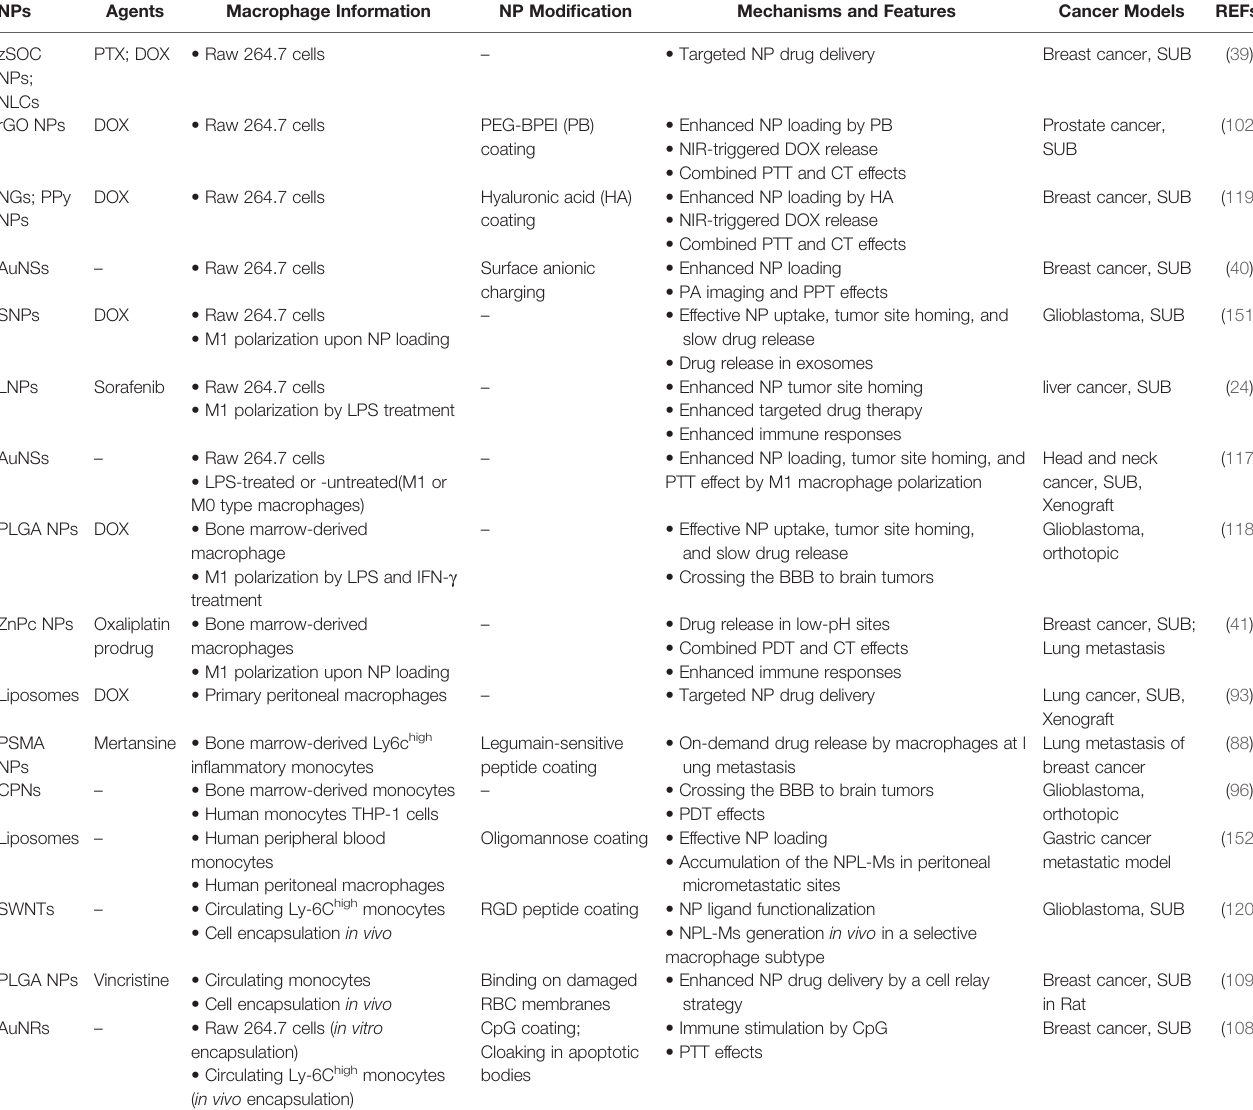
TABLE 2 | Macrophage-mediated NP drug delivery in some cancer studies. NPs